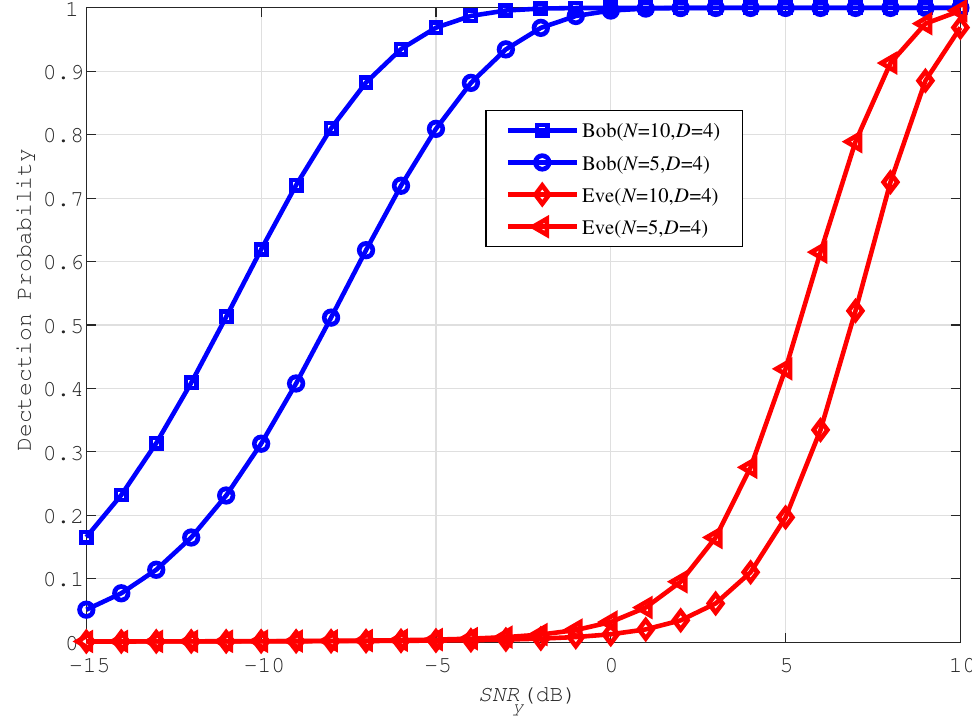
Figure 7. Signal detection performance of Bob and Eve over AWGN